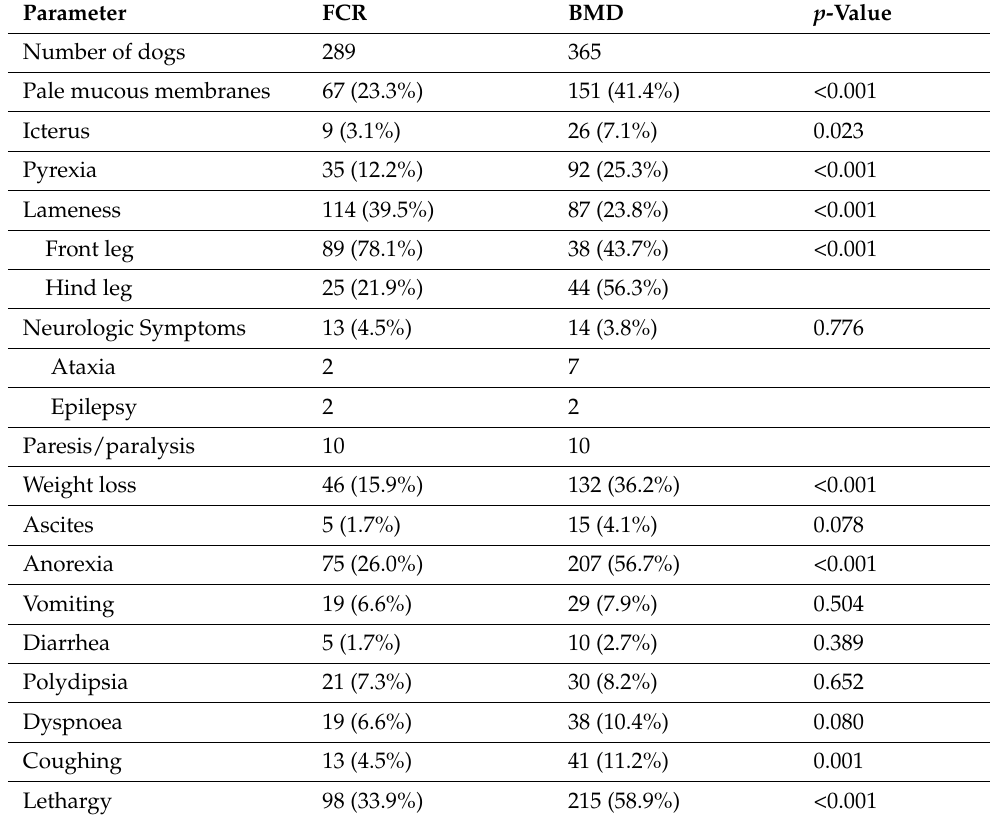
Table 2. Comparison of clinical signs in FCR and BMD with